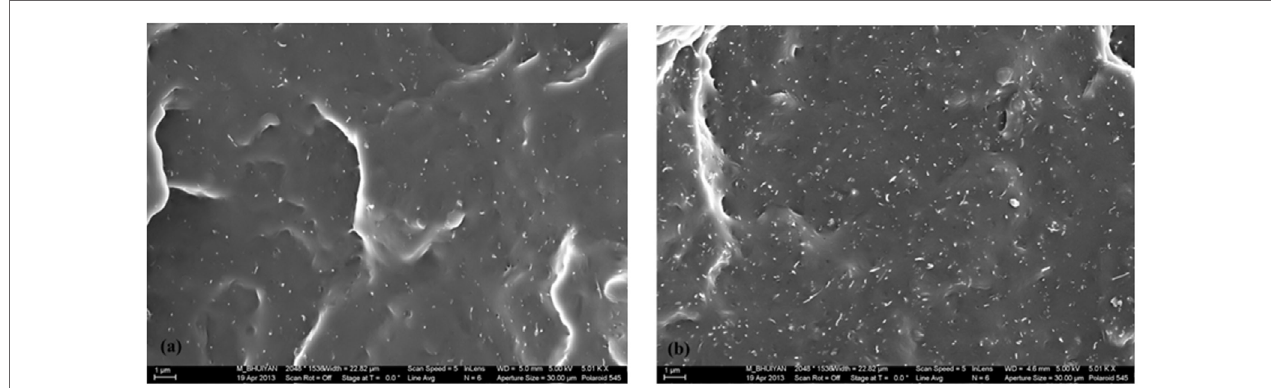
composites.FigUre 7 | seM images of the fracture surfaces of 4 wt% cnT/PP composites with (a) sDBs-modified cnT; and (B) non-modified